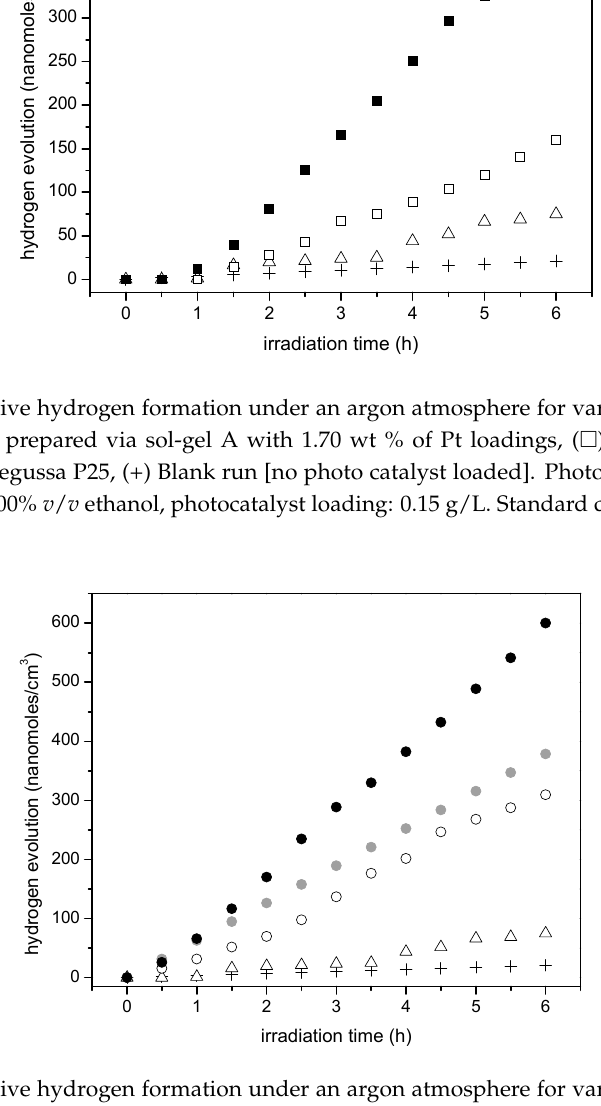
Figure 11. Cumulative hydrogen formation under an argon atmosphere for various photocatalysts using: ( ● ) ( ● ) ( ○ ) Pt–TiO 2 prepared via sol-gel B with 2.50 wt. % and 1.00 wt. % Pt, ( Δ ) Degussa P25, (+) Blank run [no photocatalyst]. Photoreaction conditions: pH = 4.00 ± 0.05, 2.00% v / v ethanol, photocatalyst loading: 0.15 g/L. Standard deviation for repeats was ±5%.